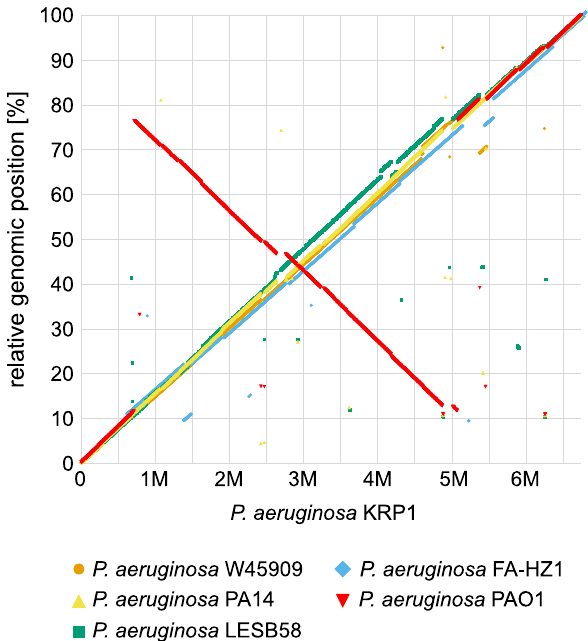
Figure 2. Synteny plot of the P. aeruginosa KRP1 strain and five other P. aeruginosa strains. Each dot represents a gene of KRP1 and its corresponding homologue in the respective comparative strain. x-axis shows the position within the chromosome of KRP1 and y-axis shows the relative position within the compared genome. Analysis was performed with the EDGAR platform 24,25 .